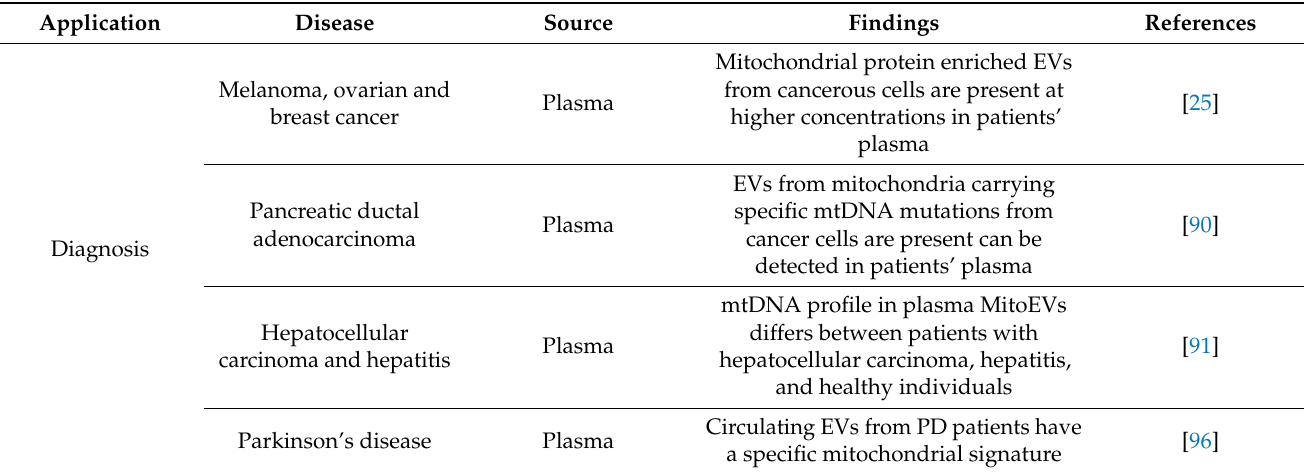
Figure 2. Graphical explanation of the potential therapeutic and diagnostic use of large and small MitoEVs. Larger MitoEVs refer to EVs that are shed from the plasmatic membrane of the cell and can include whole mitochondria; these EVs are particularly interesting in the field of mitochondrial transfer as therapeutic vehicles. Small MitoEVs are included in MVB previous to their release and contain material from the mitochondrial origin (mtDNA and proteins); its analysis may serve as a diagnostic tool in liquid biopsies. Table 1. Summary of applications of MitoEVs in human diseases, regarding the sources of the vesicles and the key findings in different studies.